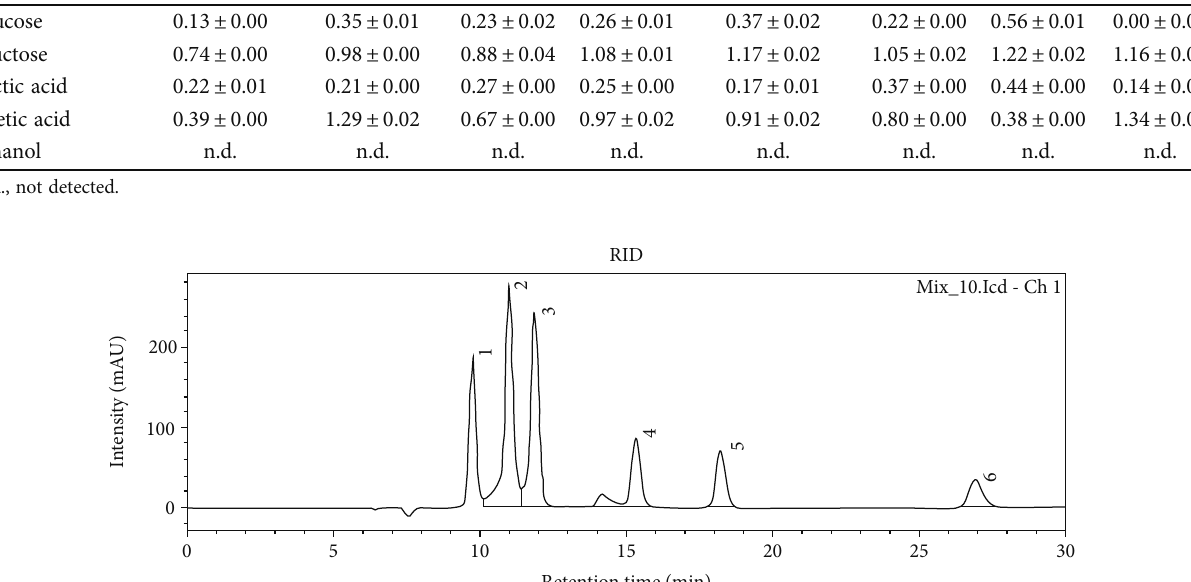
Table 2: The concentration of sugars, organic acids, and ethanol in cocoa bean samples from various regions of Indonesia. Parameter (mg/g)